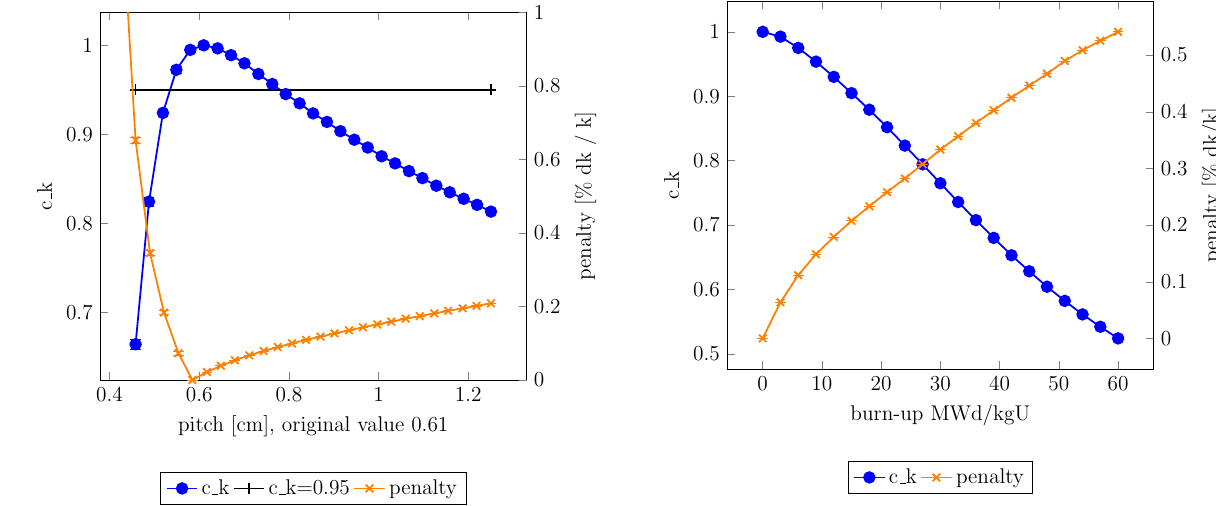
Figure 5. Comparison of irradiated fuel with fresh UO 2